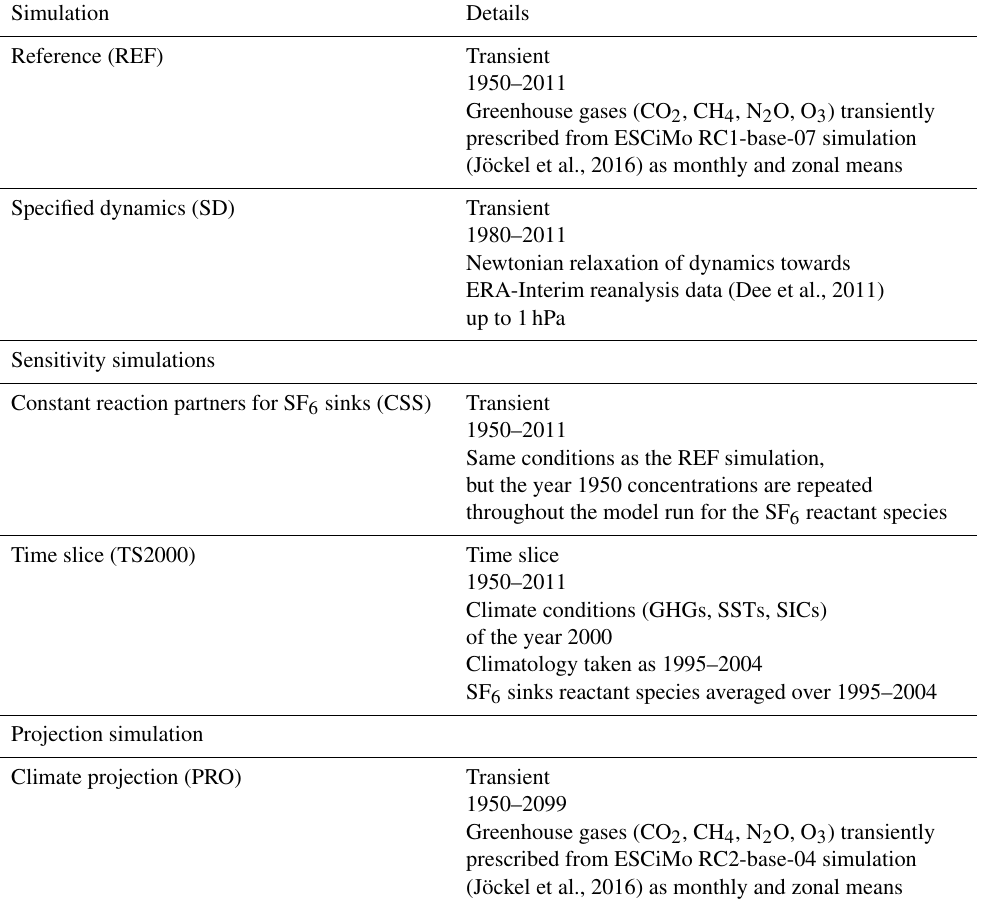
Table 2. Overview of simulations undertaken in this study